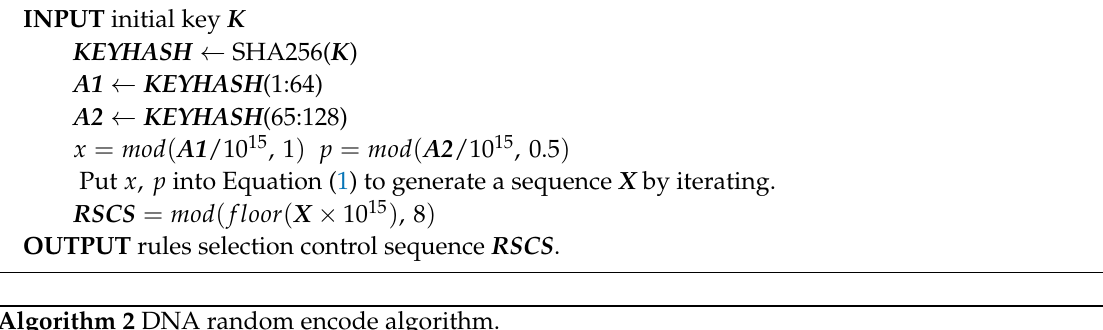
Algorithm 2 DNA random encode algorithm. INPUT rules selection control sequence RSCS and data array A